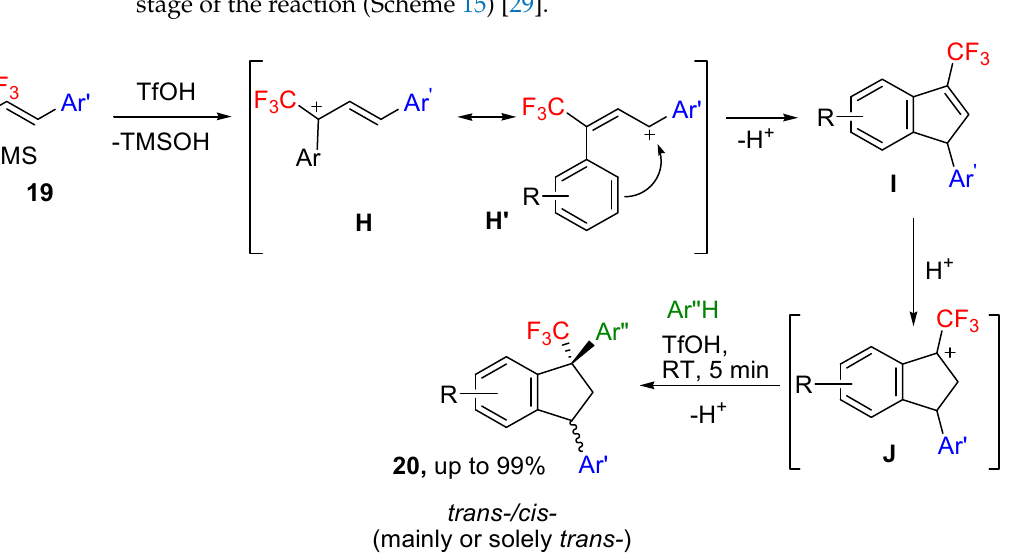
Scheme 15. TfOH-promoted synthesis of 1-CF 3 -indanes 20 from CF 3 -allyl alcohols 19 and